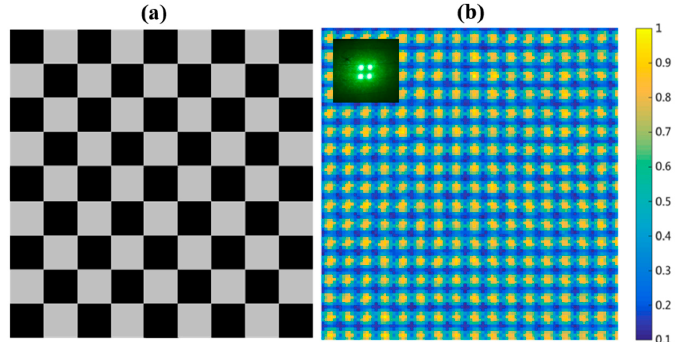
Figure 4. The spatial light modulator (SLM) pattern and the multifocal array. ( a ) The subareas of the load on the SLM. ( b ) The multifocal at the focal plane, where the inset is the spatial distribution of the remaining two sets of ±1 order diffraction beams.